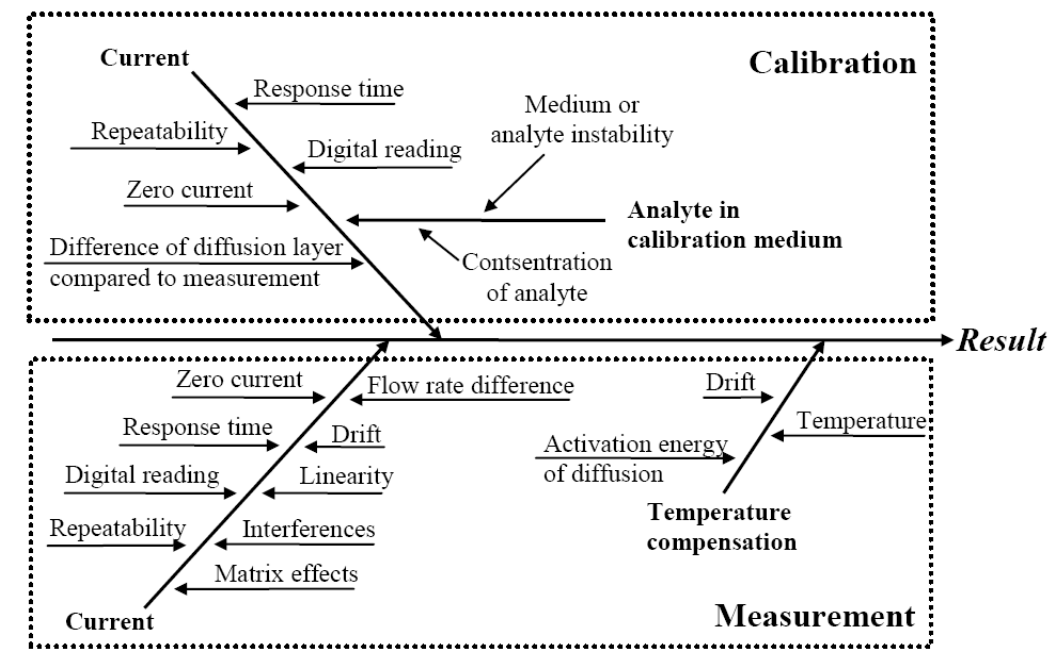
Figure 1. Uncertainty sources in amperometric